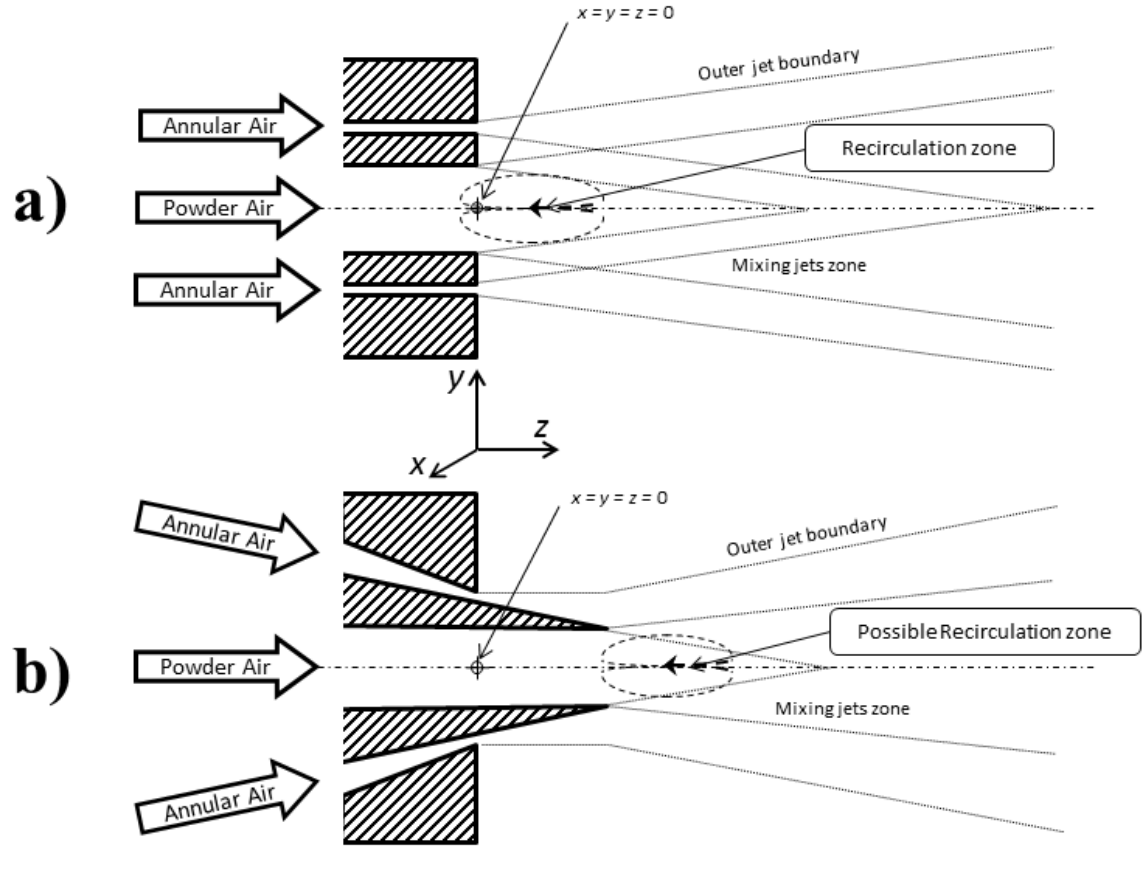
Figure 1. ( a ) Schematic longitudinal section through Gun Head 1; ( b ) Schematic longitudinal section through Gun Head 2.